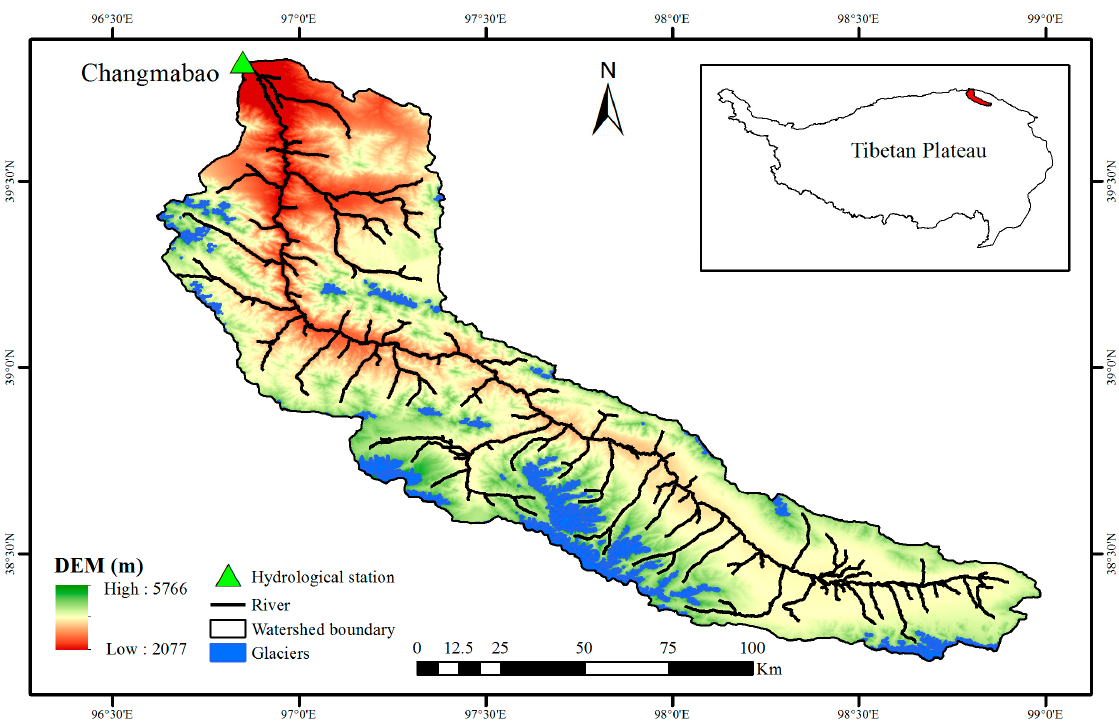
Figure 1. Map of the upper reach of the Shule River Basin (URSRB).